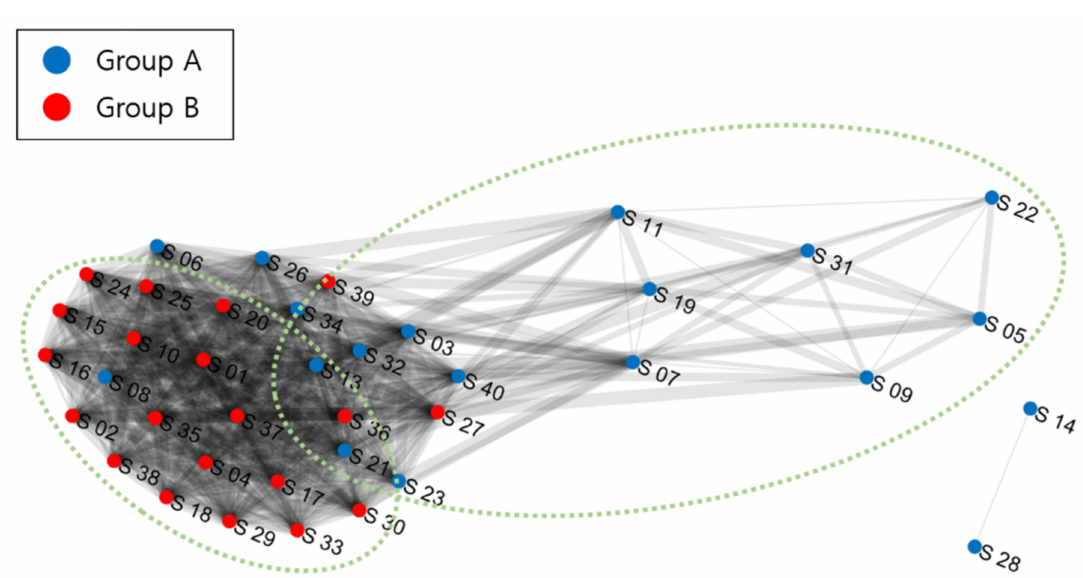
Figure 10. Network graph for the feature “Hard